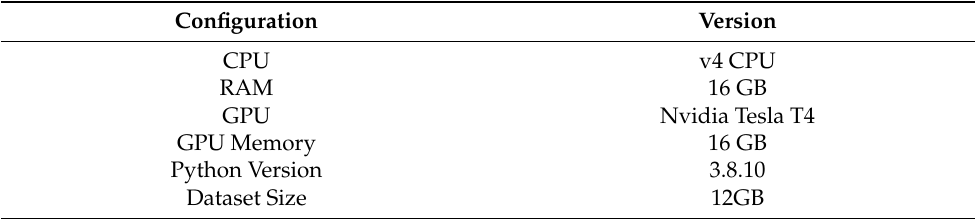
Table 1. Experiment environment.